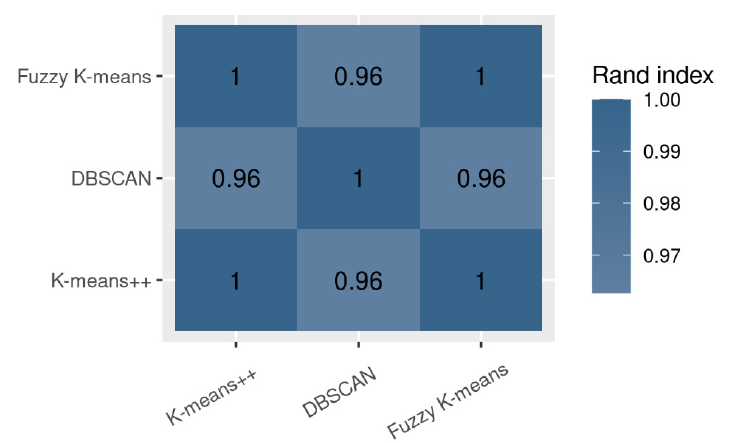
Figure 9. Adjusted Rand index (ARI).